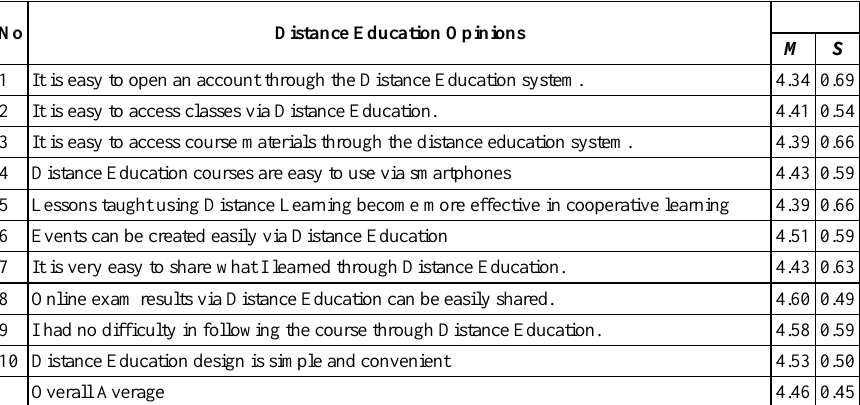
Table 5. Views of university students on distance